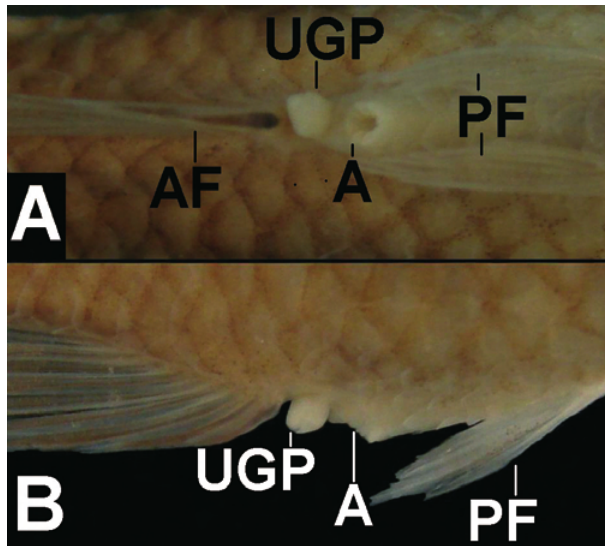
Fig. 53. Urogenital region of female of Phalloceros titthos , MZUSP 79670. (A) ventral view; (B) lateral view of left side, pelvic fin. A = anus; AF = anal fin; UGO = urogenital opening; UGP = urogenital papilla. Scale bar 1